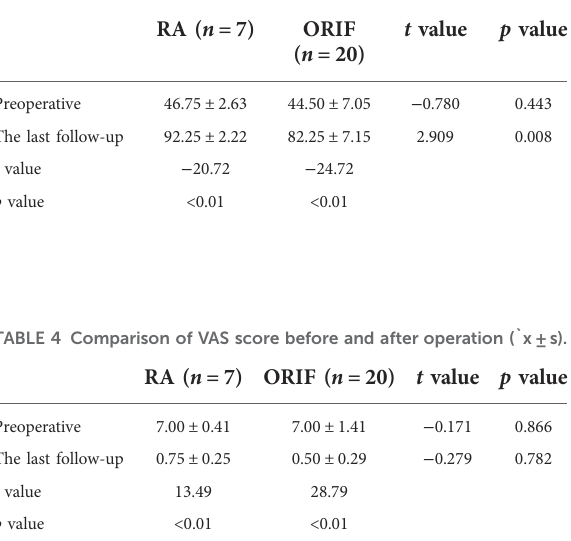
TABLE 3 Comparison of AOFAS score before and after operation (`x±s).